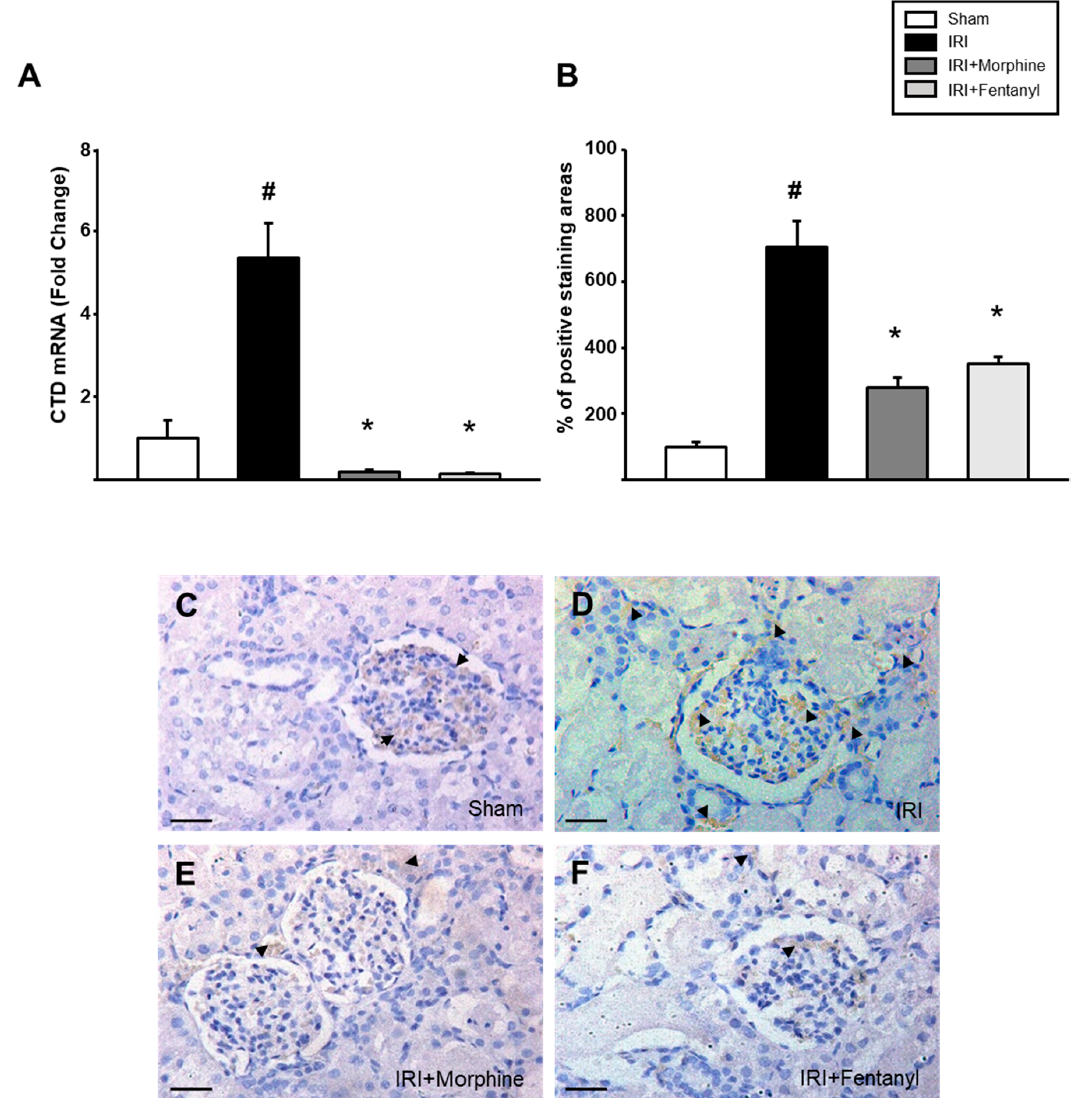
Figure 6. Opioid preconditioning reduced CTD expression. ( A ) CTD mRNA expression was examined by real-time PCR. Immunohistochemistry was executed in the ischemia-reperfusion treated left kidney and areas with positive staining ( B ) from the sham group ( C ), IRI ( D ), morphine- ( E ) and fentanyl-preconditioned rats ( F ) were quantified. Sham group is represented by the white bars, IRI by the black bars, IRI + morphine by the dark gray bars and IRI + fentanyl by the light gray bars. The average count of positive staining areas in the sham group was set as 100%. Scale bars represent 50 µm. Values are means ± S.E.M. ( n = 6). # p < 0.05 vs. sham, * p < 0.05 vs. IRI.